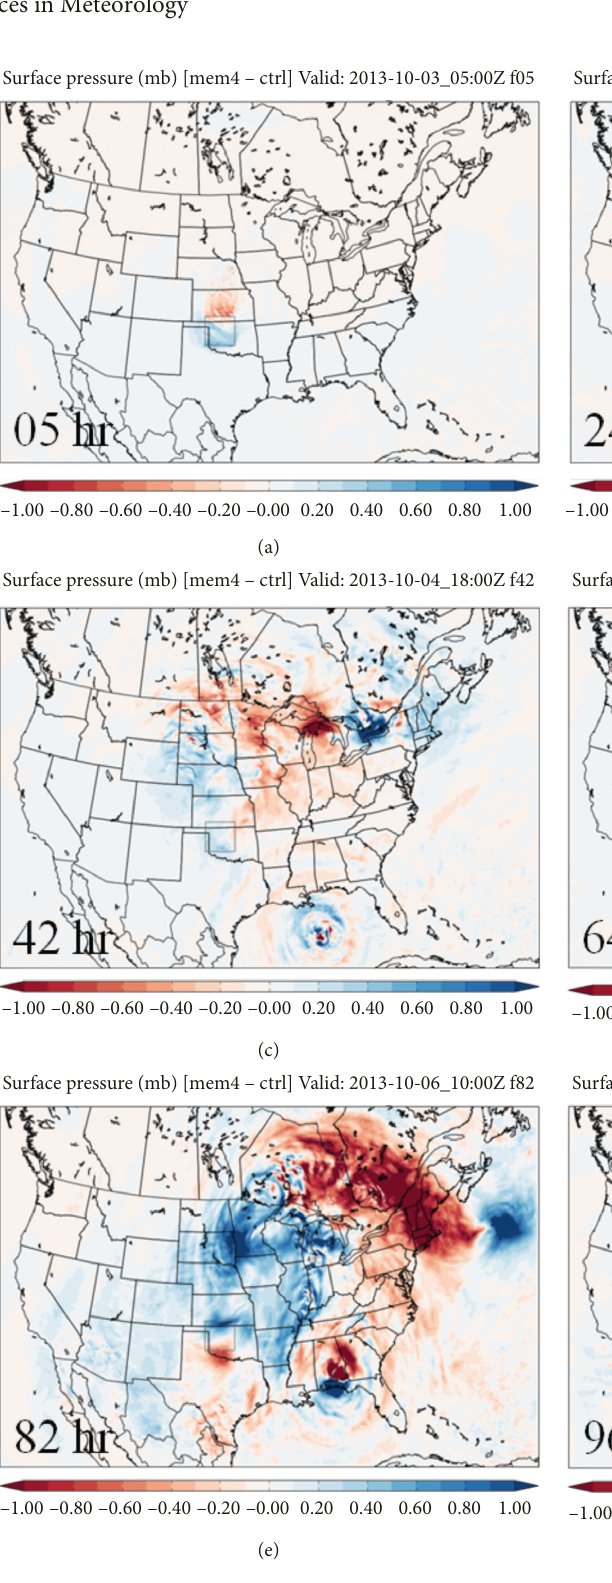
Figure 8: Surface pressure perturbations at forecast hours 05 (a), 24 (b), 42 (c), 64 (d), 82 (e), and 96 (f) for the 3 October 2013 case due to a wind farm in box shown in